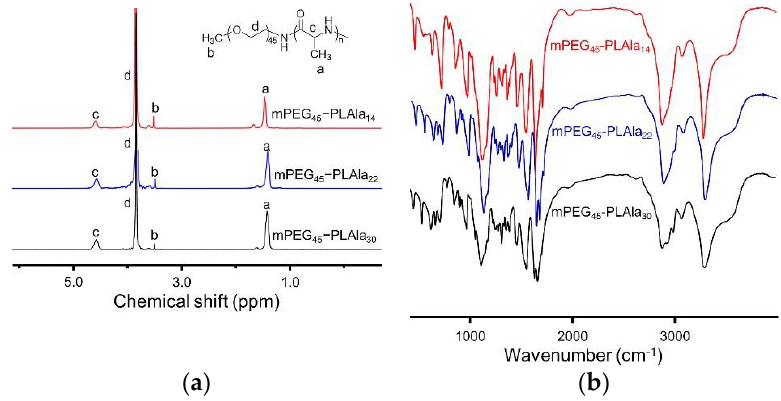
Figure 1. Structure characterization of mPEG 45 −PLAla. ( a ) 1 H NMR spectra of mPEG 45 −PLAla 30 , mPEG 45 −PLAla 22 , and mPEG 45 −PLAla 14 , where the subscripts indicate the degree of polymerization (DP); ( b ) Fourier-transform infrared (FT-IR) spectra of mPEG 45 −PLAla 30 , mPEG 45 −PLAla 22 , and mPEG 45 −PLAla 14 .